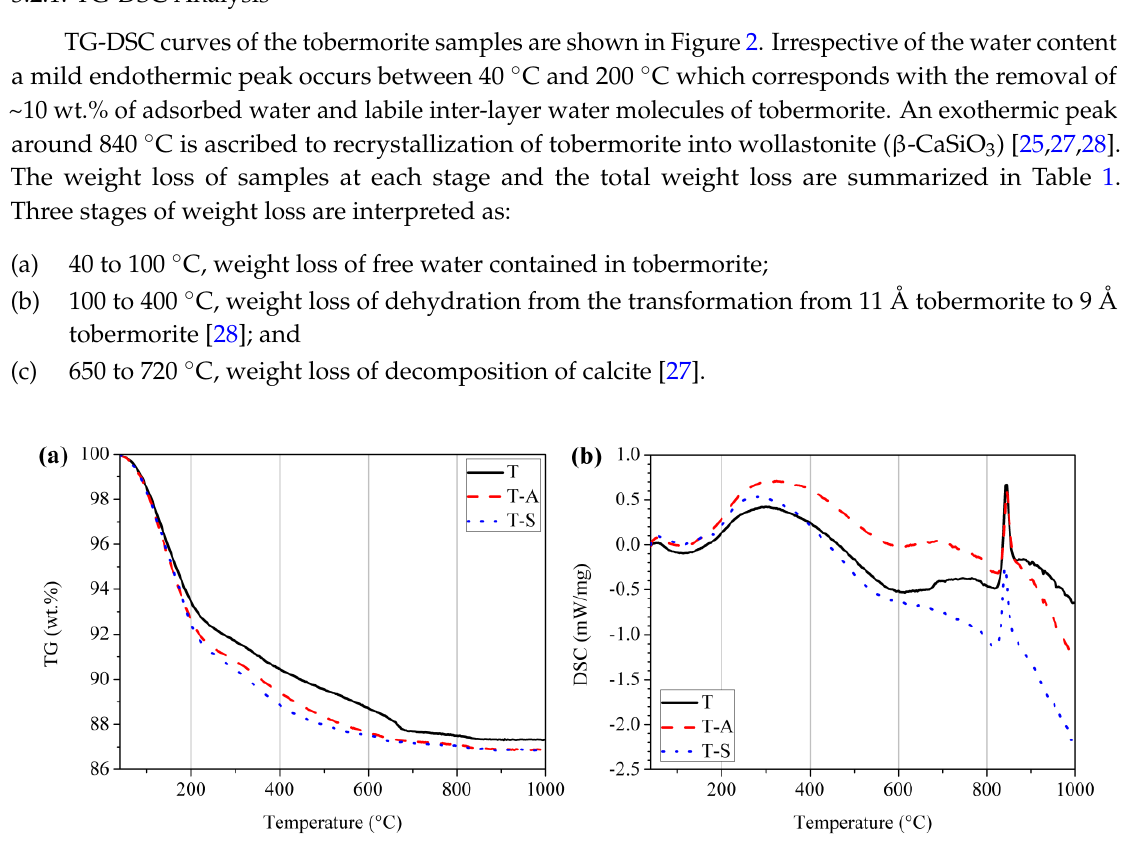
Figure 2. Thermogravimetry ( a ); and differential scanning calorimetry ( b ) curves of the tobermorite samples. Table 1. Weight change proportion according to Figure 2.